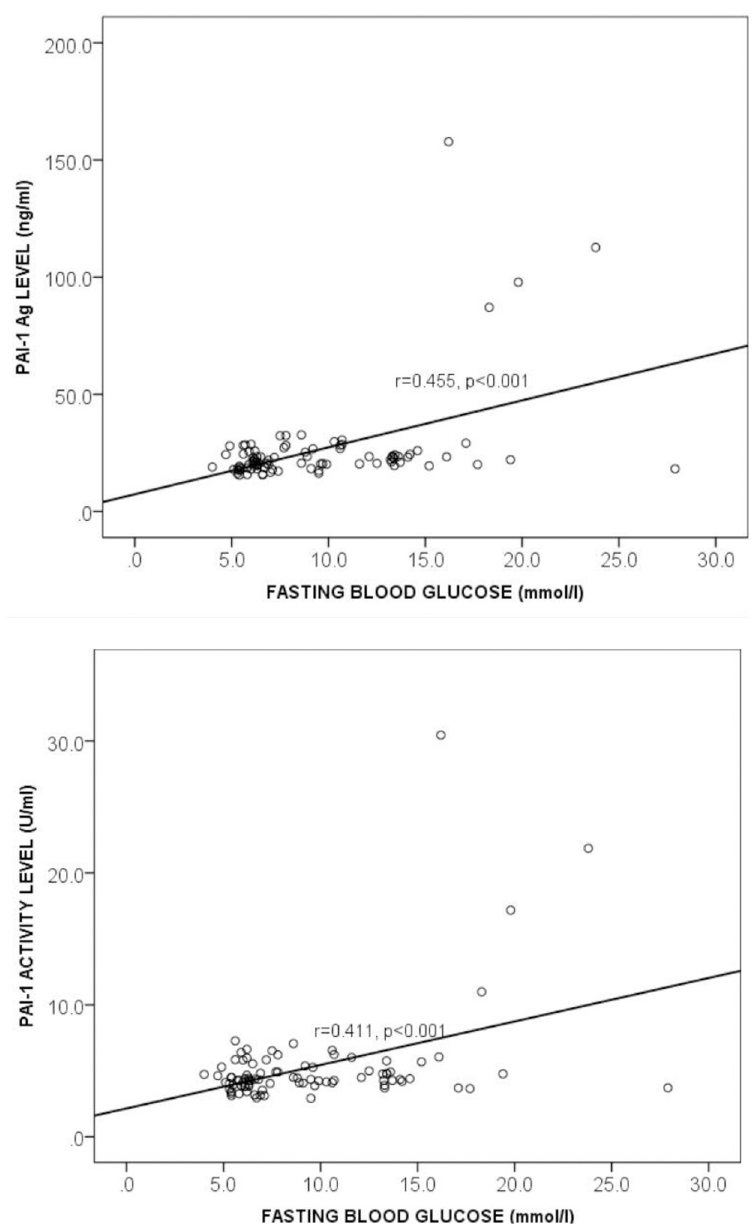
Fig 3. Correlation between Plasminogen Activator Inhibitor-1 and fasting blood glucose among the study participants levels. FBG = fasting blood glucose, PAI-1 Ag = Plasminogen activator inhibitor 1 antigen, r = Correlation coefficient. Spearman correlation was used to determine the correlation between the plasma PAI-1 antigen and FBG (Fig 3a) and PAI-1 activity and FBG (Fig 3b). p < 0.05 was considered statistically significant.